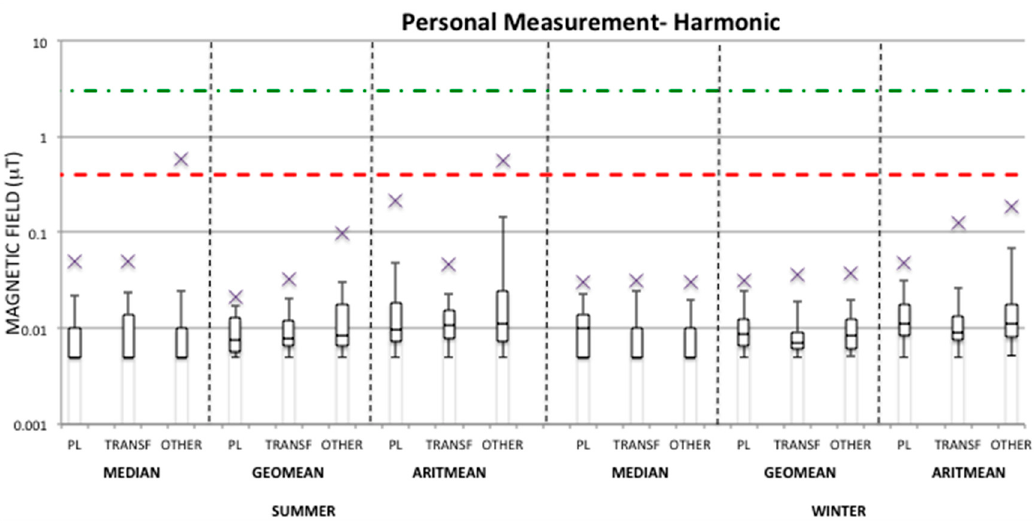
Figure 3. Distribution of the median, geometric mean, and arithmetic mean of magnetic field ( μ T) in the harmonic frequency range (100–800 Hz) indicated as box-plots for personal measurements in both summer and winter periods and in each group (PL, TRANSF, OTHER). The distribution values are indicated in Appendix Table A3.